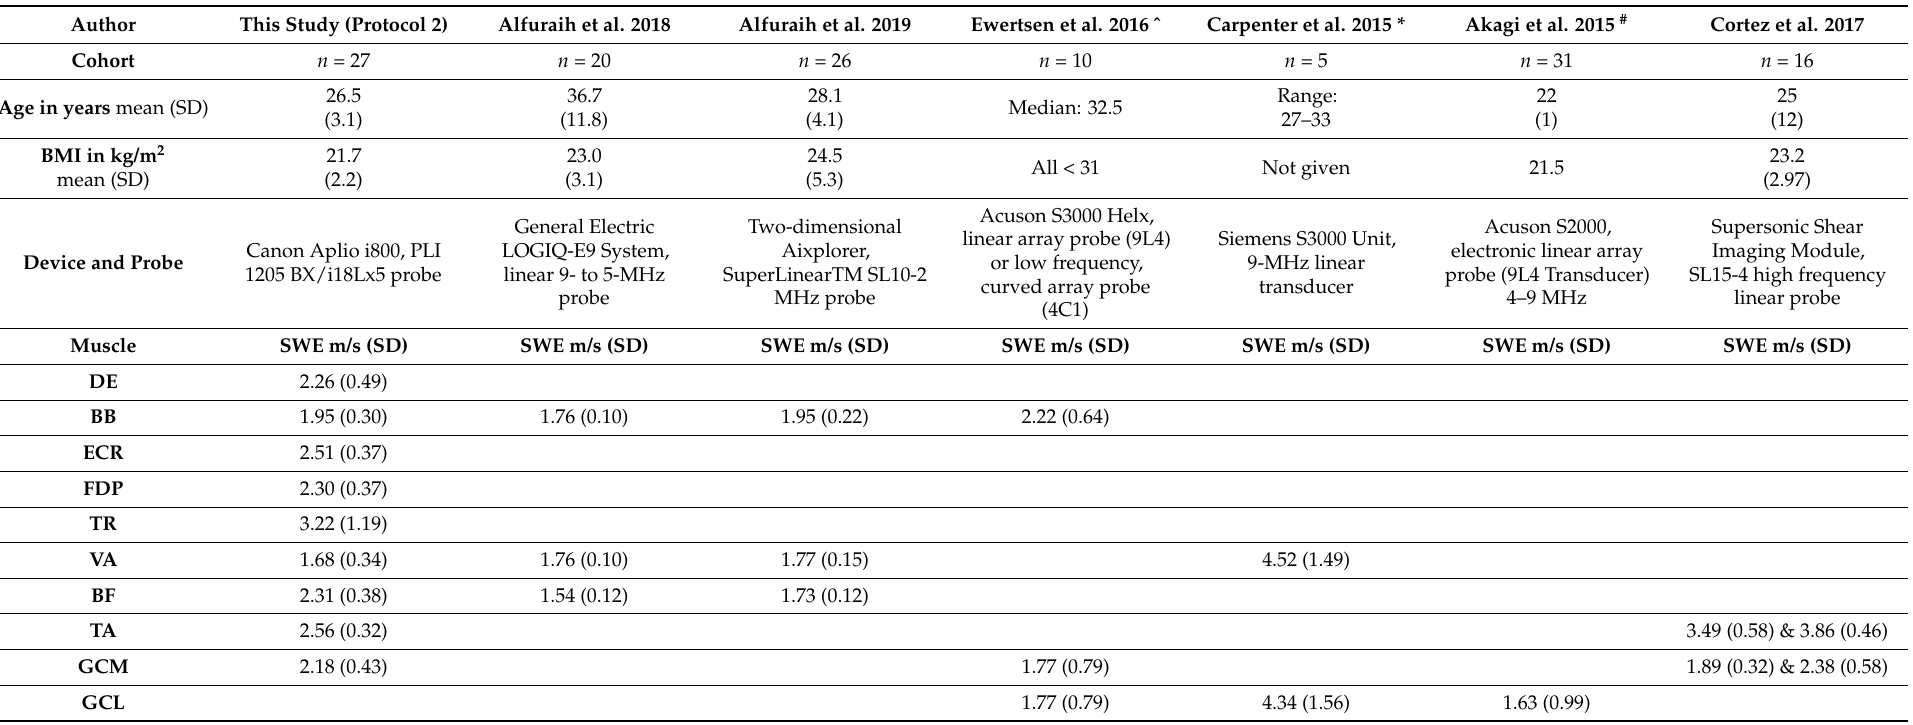
Table 4. Summary of muscle SWE reference values (SWV in m/s), sorted by muscle and by